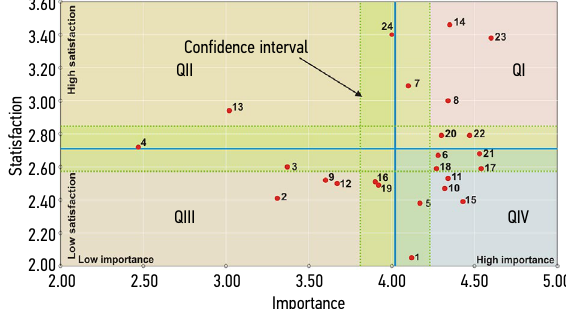
Fig. 3. Introduction of confidence